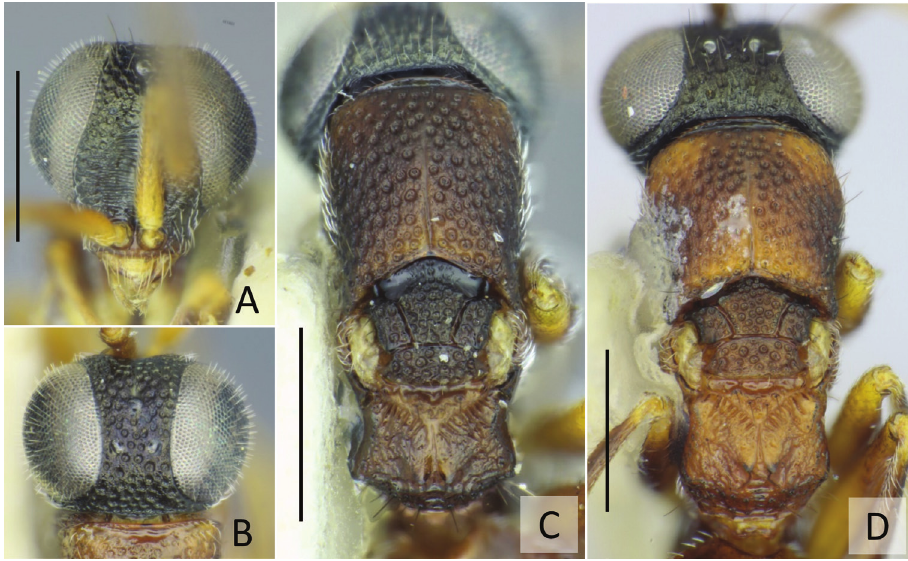
Figure 3. Baeosega humida Krombein ♀ A holotype of B. humida , head in frontal view B ditto, dorsal view C ditto, mesosoma D holotype of B. laticeps , mesosoma. Scale bars: 0.5 mm.